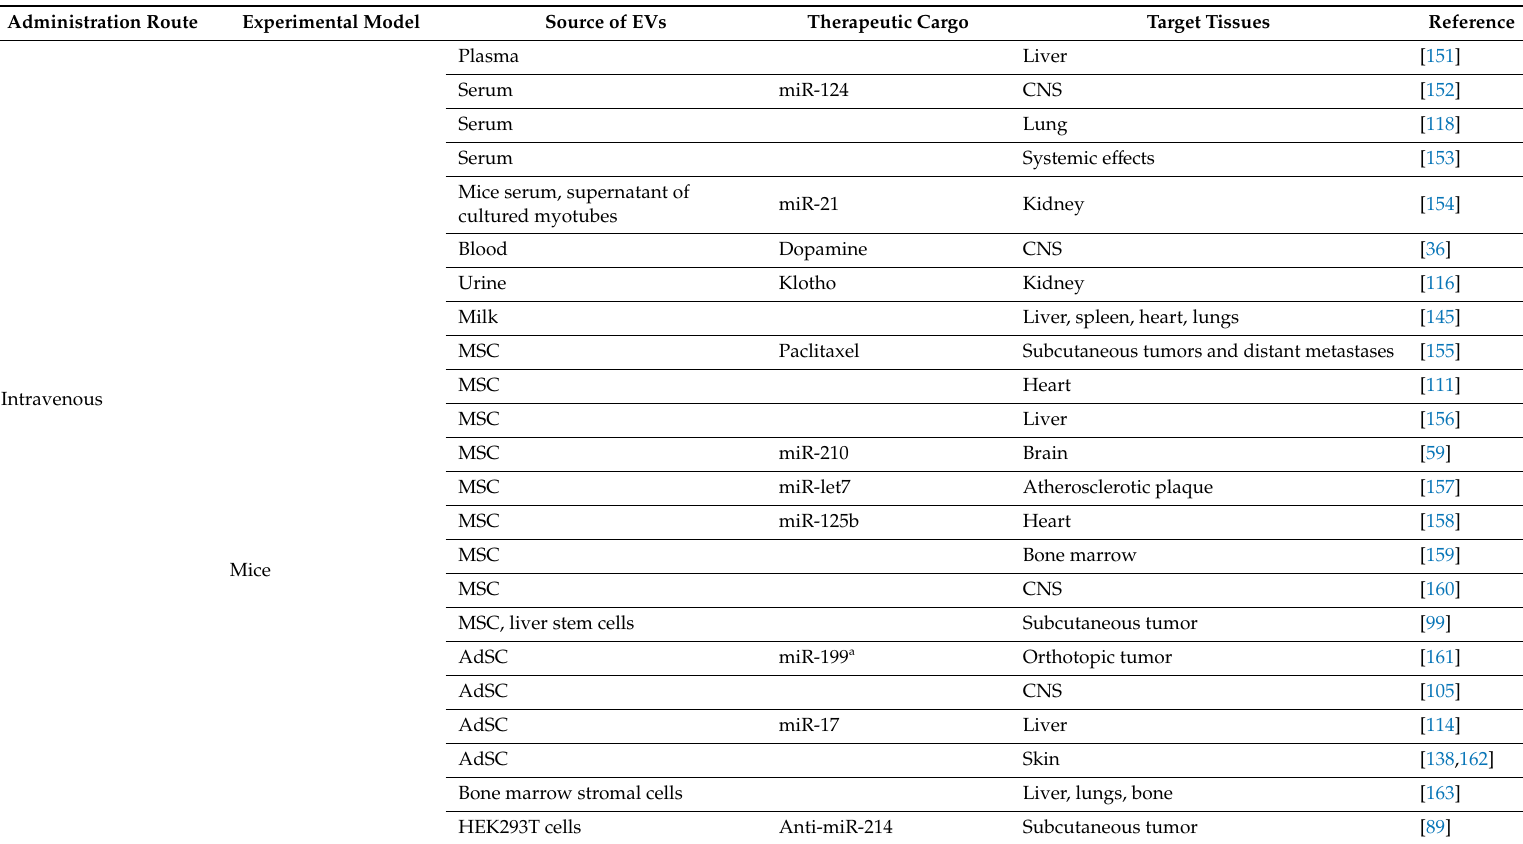
Table 2. Administration routes for EVs in vivo. Detailed are di ff erent studies using in vivo models where EVs were administered. Described are the administration routes, the experimental model, the source of EVs, the therapeutic cargo (when known), and the target tissue of the EVs or the EV-related e ff ects. While in some cases a therapeutic cargo was known, in other cases the EV itself was the therapeutic agent and no particular component of the cargo was specified as responsible for the e ff ect observed. Abbreviations: AdSC: adipose tissue-derived stem cells; CNS: central nervous system; miR: micro RNA; MSC: mesenchymal stem